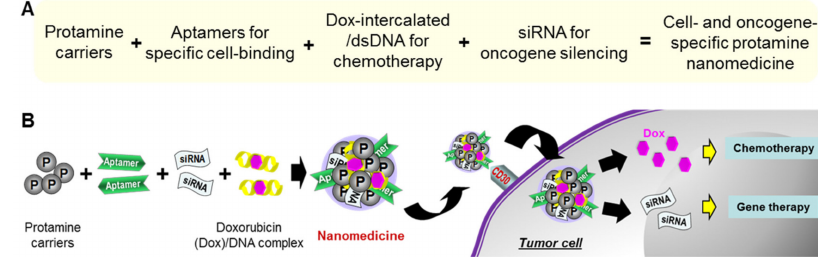
Figure 1. ( A ) Fabrication scheme of protamine nanomedicine. ( B ) Precision cancer therapy by protamine nanomedicine.